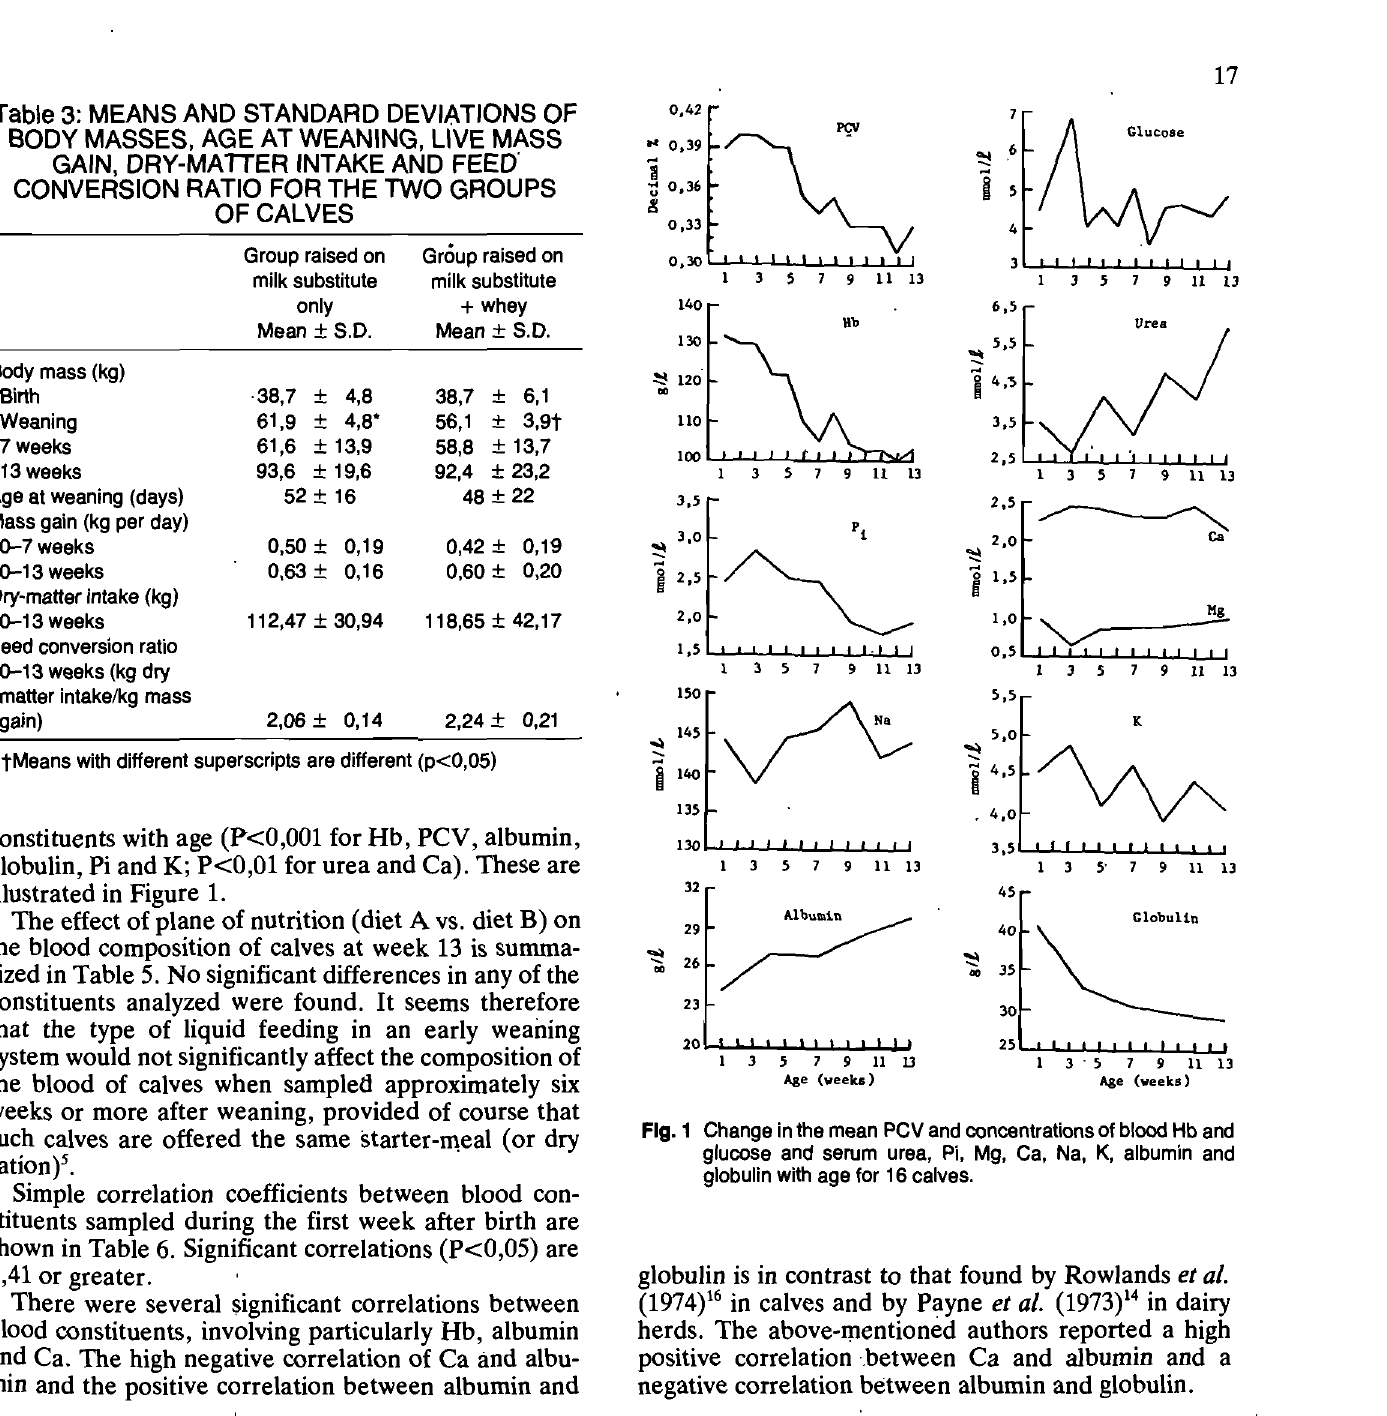
Table 4: MEANS, RANGES, STANDARD DEVIATIONS AND COEFFICIENtS'OF-VARIATION OF BLOOD CONSTITUENTS SAMPLED DURING WEEK 1 AND WE~K13'(n=16)